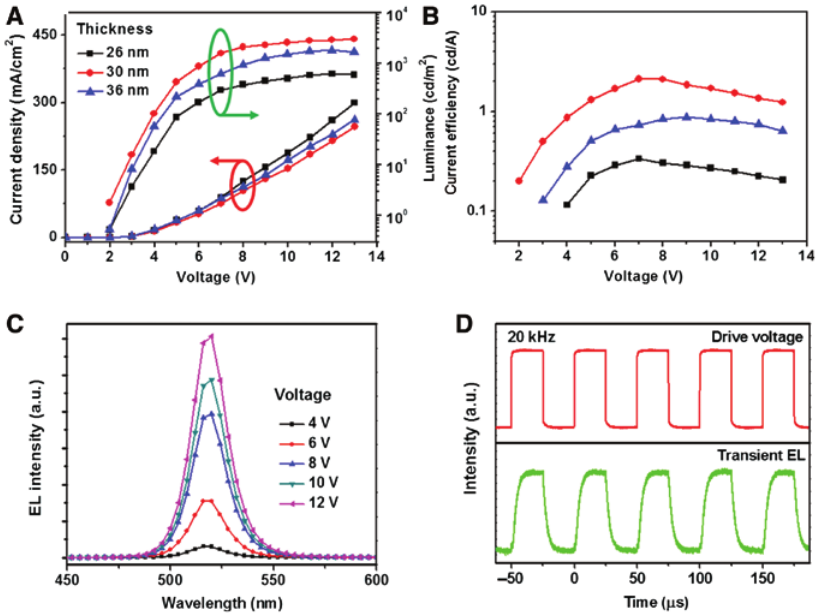
Figure 4: Electroluminescence characteristics of the bi-functional diodes. (A) J – L – V characteristics and (B) current efficiency measured for the bi-functional diodes with different active layer thicknesses of 26 nm, 30 nm and 36 nm. (C) Typical EL spectra measured for the bi-functional diode at different forward biases. (D) The transient EL characteristics of the bi-functional diode operated by a 5 V 20 kHz-modulated power source. The profile of the 20 kHz-modulated bias also is plotted for